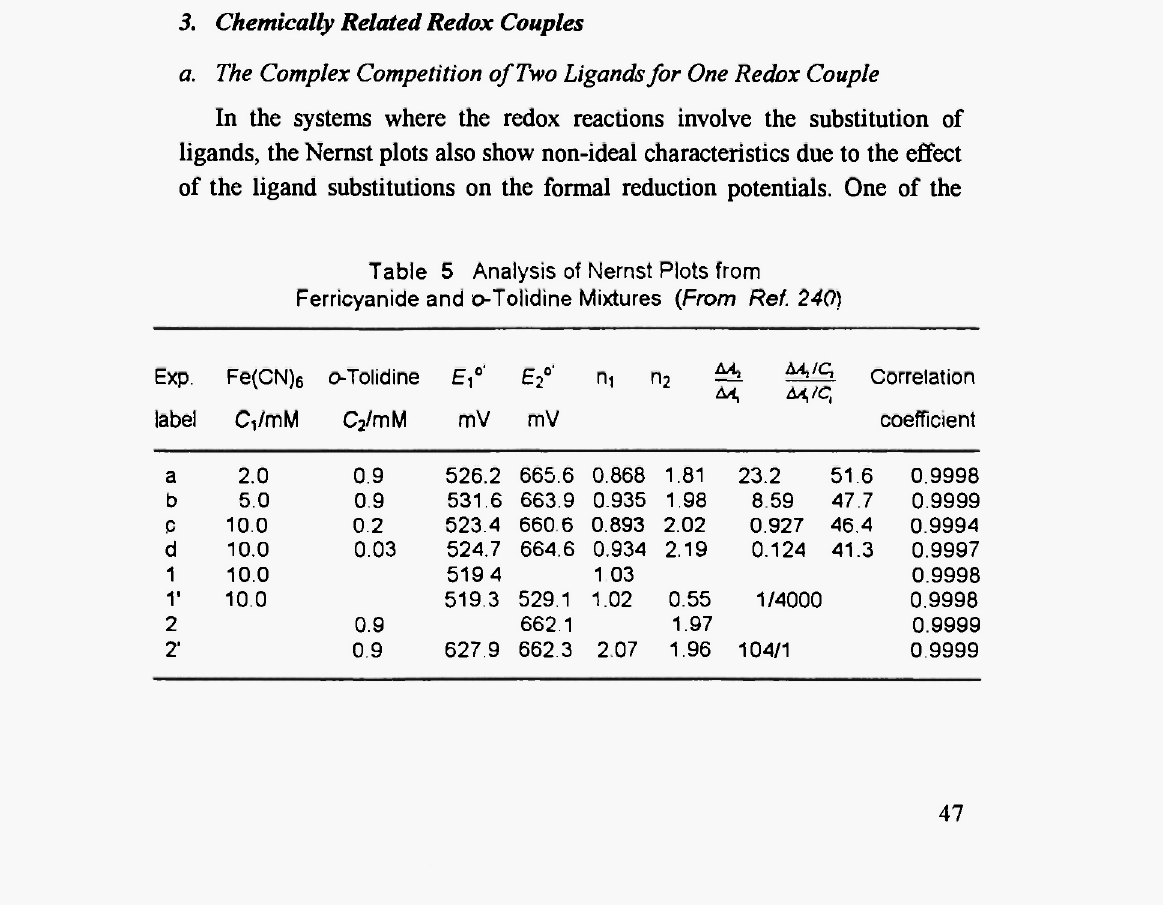
Table 5 Analysis of Nernst Plots from Ferricyanide and o-Tolidine Mixtures (From Ref.